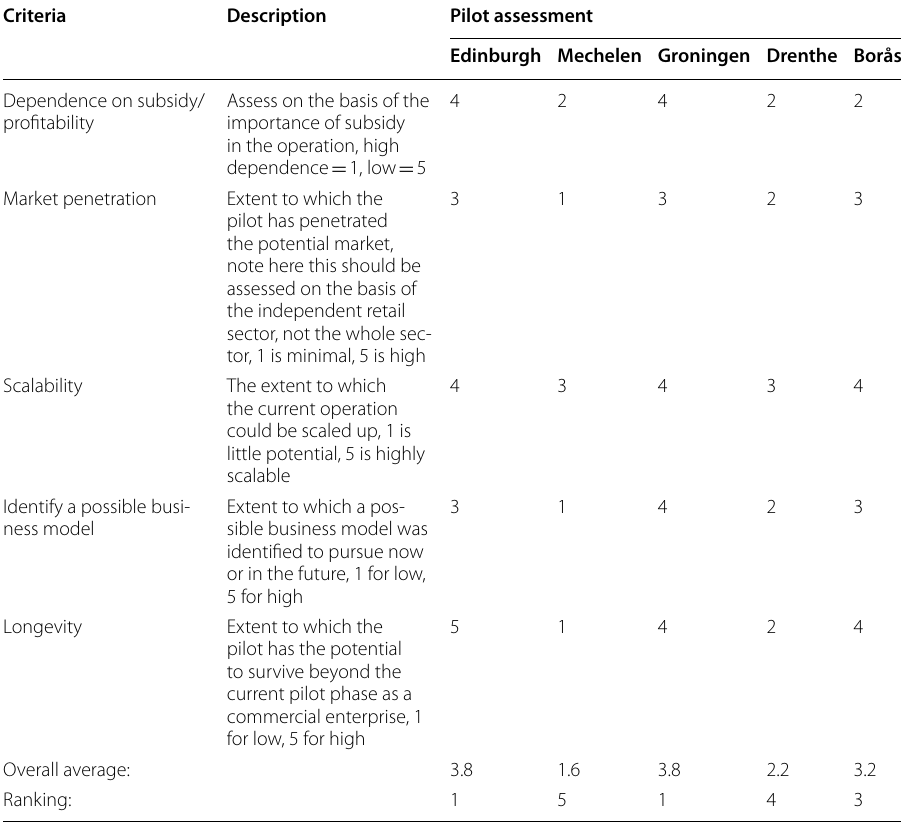
Table 3 Result of delphi panel analysis Criteria